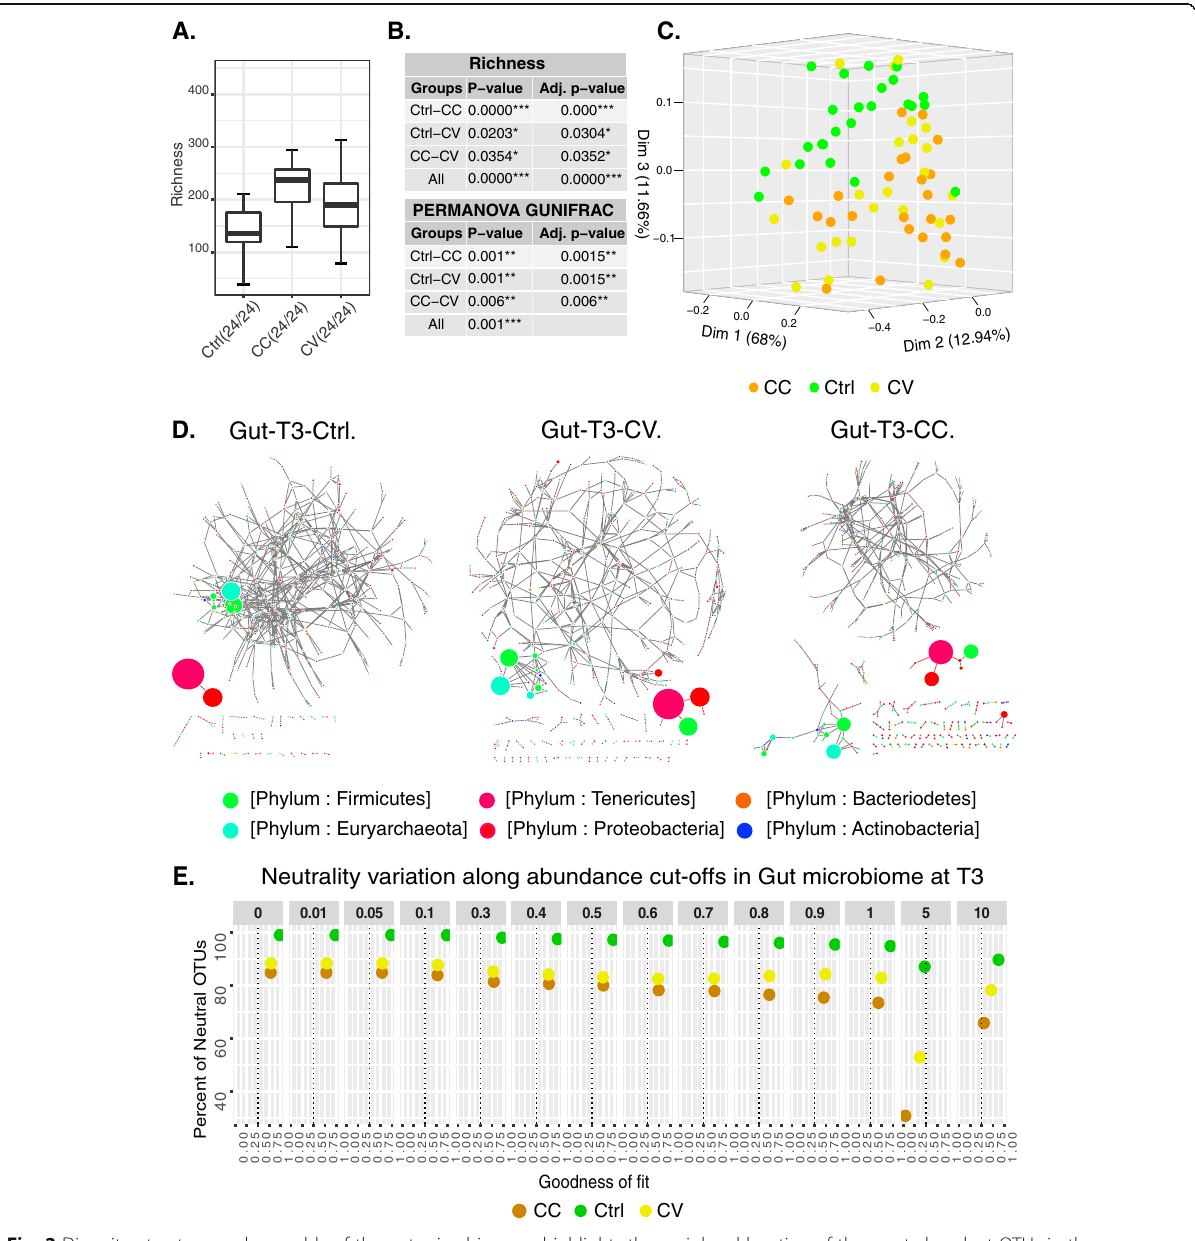
Fig. 2 Diversity, structure, and assembly of the gut microbiome. a highlights the peripheral location of the most abundant OTUs in the correlation networks of the gut microbial community. Each node size in the network is proportional to the average of the OTUs relative abundance in all samples. These networks are based on significant Spearman coefficients and were constructed using R scripts and Cytoscape software. b shows the boxplots of the significant difference in alpha-diversity (Shannon effective). c summarizes the statistical tests of alpha- diversity and beta-diversity (Gunifrac distance). d represents the PCOA 3D plot of the microbial skin communities of all treatment groups based on the significant difference of generalized Unifrac distances tested with PERMANOVA, MRPP and multiple correction test (See Materials and Methods and Supplementary Table 3) ( e ) reports the distribution of neutrality versus abundance cut-off and goodness of fit. The plot shows the variation of neutral OTUs percentage (Y-axis) along with the goodness of fit predicted by NLS models using 12 cut-offs of relative abundance percentages (facet panels) in the gut metacommunity at T1 and